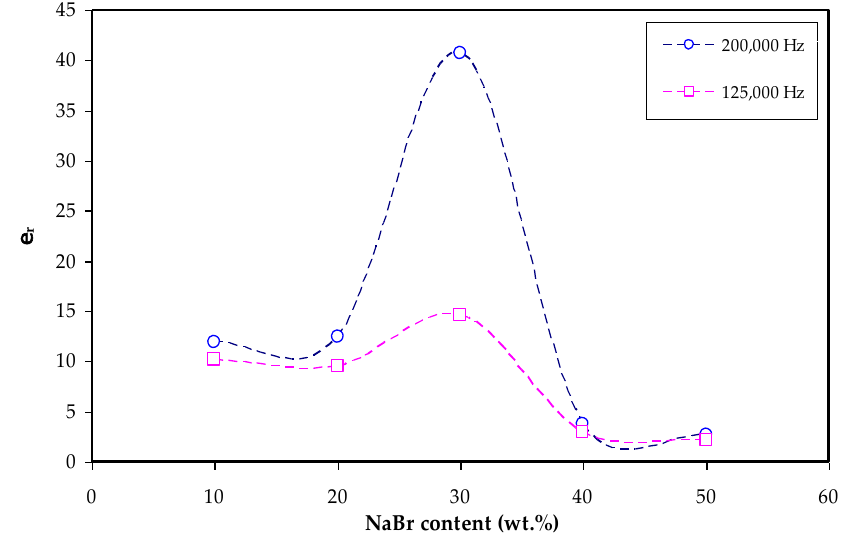
Figure 7. ε r (at 200,000 and 125,000 Hz) vs. NaBr concentration.